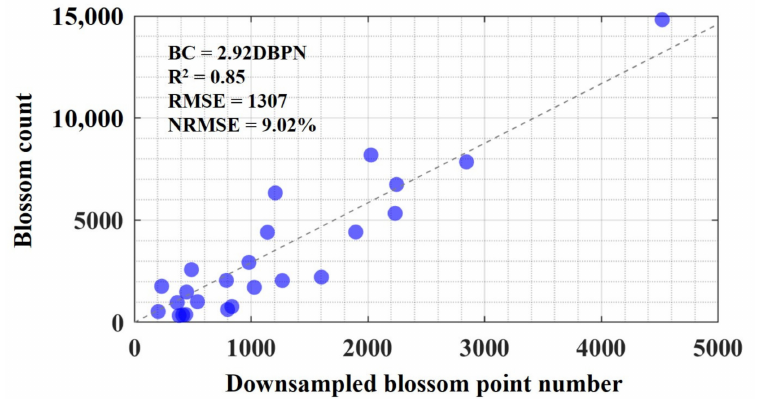
Figure 7. The best regression relationship achieved between downsampled blossom point number and manual blossom count using a 0.04 white color threshold and a 0.09 m × 0.09 m × 0.09 m blossom grid